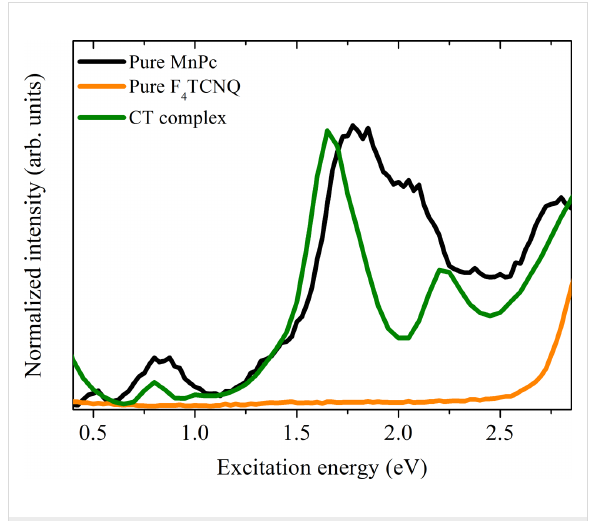
Figure 8: Comparison of the electronic excitation spectra of MnPc, F 4 TCNQ and the charge-transfer compound MnPc/F 4 TCNQ (adapted from